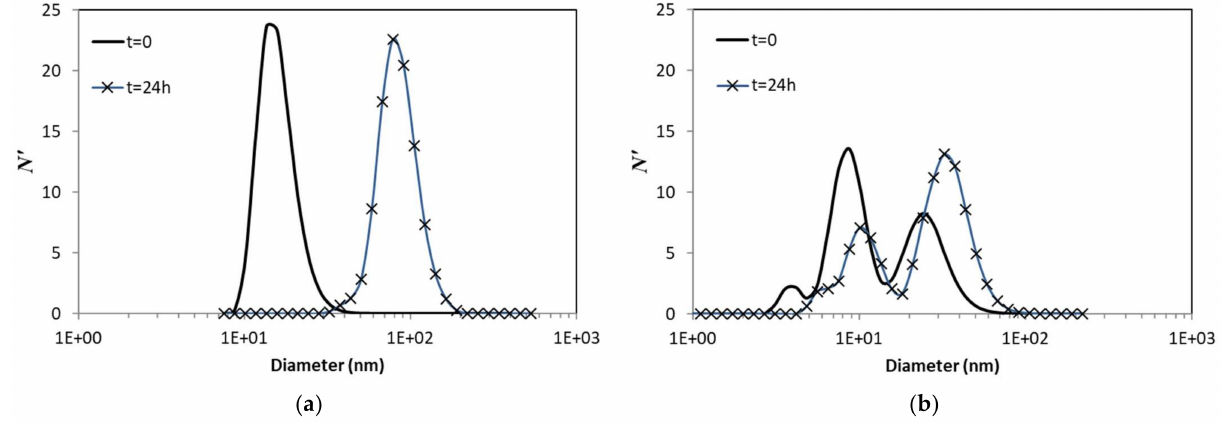
Figure 4. Initial and 24-h size distribution of IONfs in ( a ) PBS and ( b ) SBF.